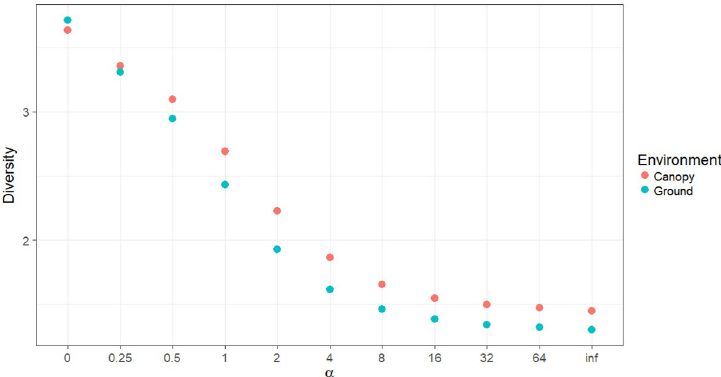
Fig 2. Re´nyi diversity profiles on the ground and canopy in Rio Pardo, Presidente Figueiredo, Amazonas State, Brazil. α -values: zero = log wealth, 1 = Shannon Index.